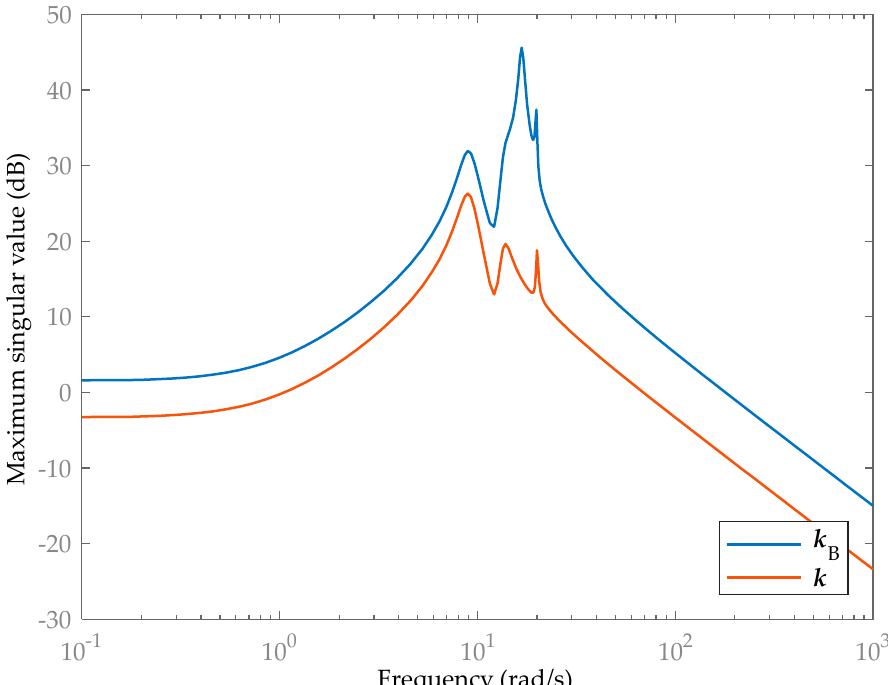
. Figure 8 corroborates the results, by